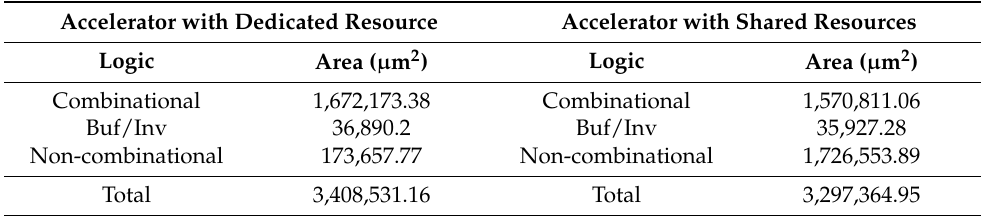
Table 4. Comparison in terms of area for dedicated vs. shared resources architectures. Accelerator with Dedicated Resource Accelerator with Shared